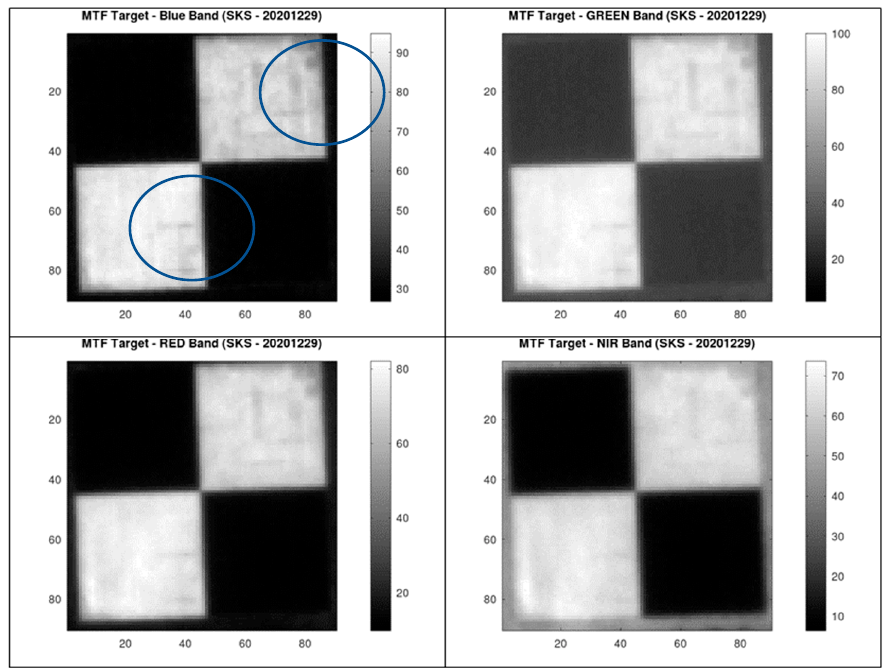
Figure 14. The SkySat image parts (29 December 2021) from the MTF target in Salon de Provence Airport and some visible degradations (blue circles). The axes are given in pixels. The legend is provided in radiance. Table 5. The MTF results obtained from SkySat-17 BAS data acquired on 29 Dec 2020 over the Salon